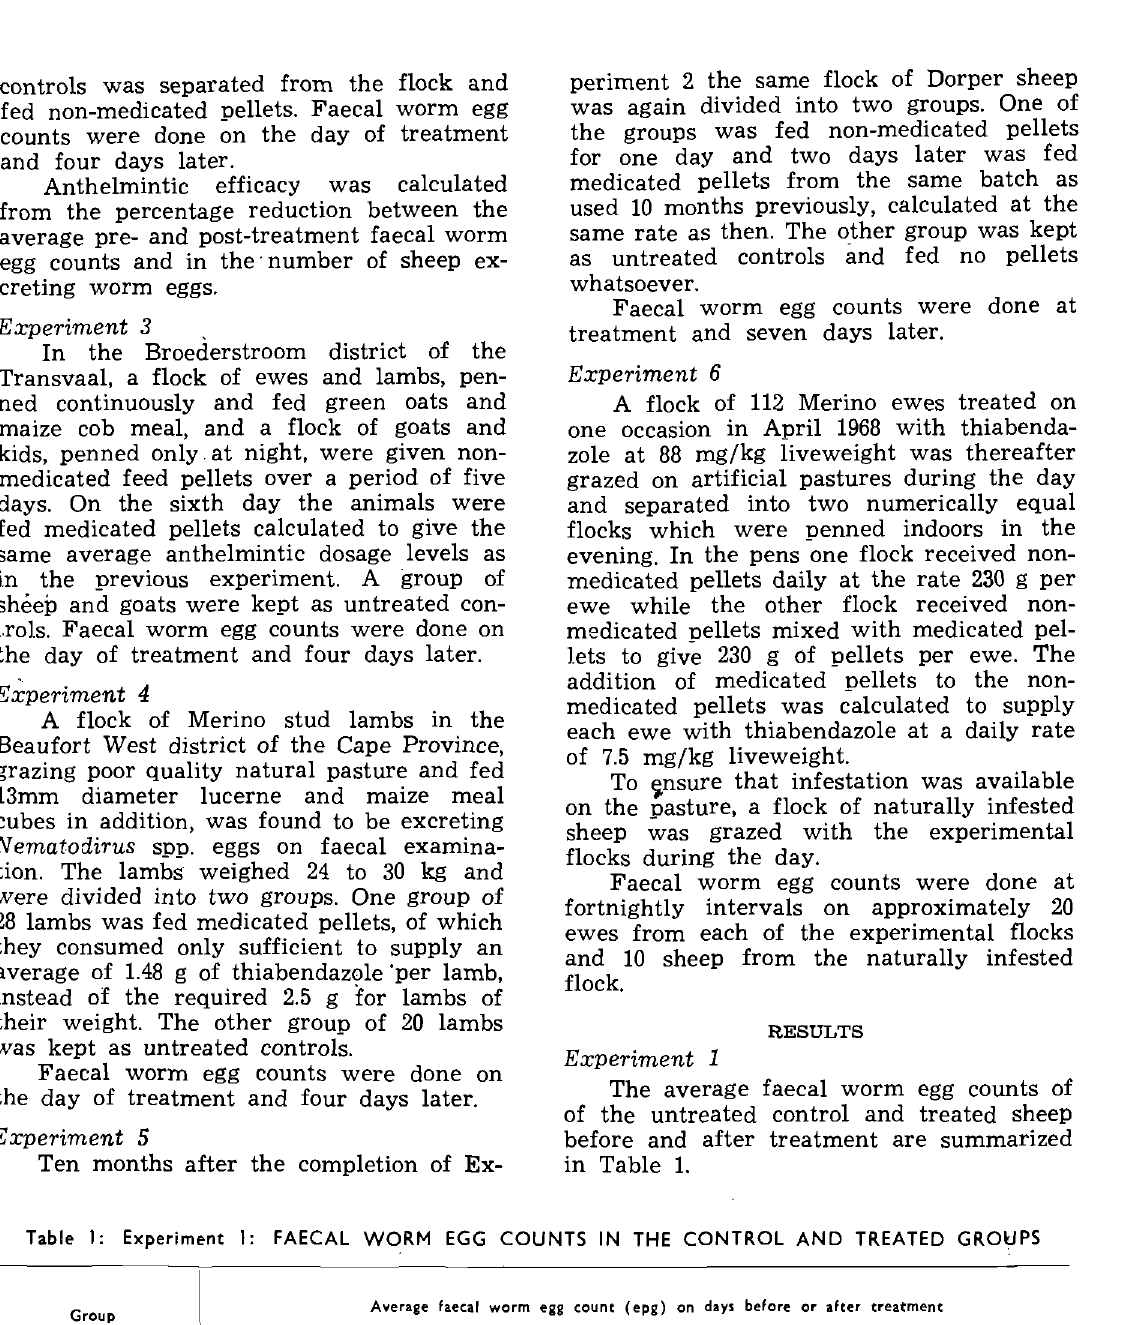
Table 1: Experiment 1: FAECAL WORM EGG COUNTS IN THE CONTROL AND TREATED GROUPS